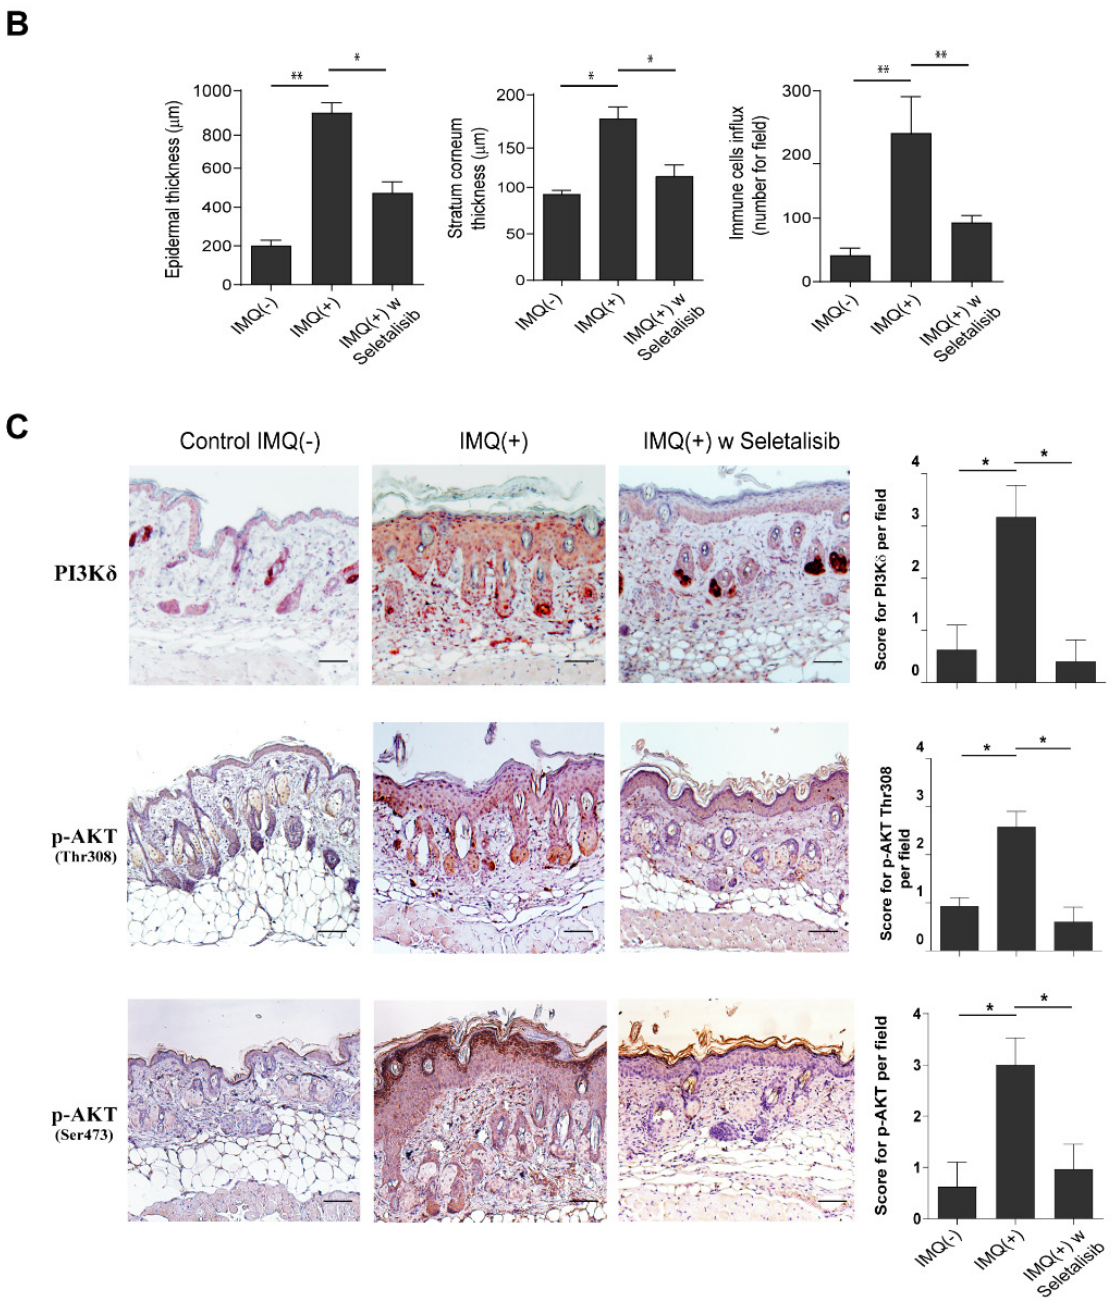
Figure 5. Ameliorative effects of seletalisib administration on pathological changes of IMQ-induced psoriasiform murine skin lesions. ( A ) Representative H&E staining of skin from Control IMQ ( − ), treated with IMQ cream (IMQ (+)), and IMQ-treated mice undergone to topical administration of seletalisib (IMQ (+) w seletalisib). Bars, 500 µ m. ( B ) The quantifications of epidermal and stratum corneum thickness, as well as of immune cell influx, were analyzed as parameters of skin acanthosis and inflammation. Graphs show means of microns of epidermis and stratum corneum thickness, and mean of number of infiltrating immune cells per section ( n = 3 sections) ± S.D. per group ( n = 2 mice for Control IMQ ( − ); n = 6 mice for IMQ (+) and n = 6 for IMQ (+) w seletalisib groups). * p ≤ 0.05 and ** p ≤ 0.01, as assessed by unpaired Student‘s t test. ( C ) IHC staining of PI3K δ isoform (red staining), p-AKT in Thr308, and in Ser473 (red-brown staining) was performed on skin of Control IMQ ( − ) ( n = 2), IMQ (+) ( n = 6), and IMQ (+) w seletalisib ( n = 6). Sections were counterstained with Mayer’s H&E and were visually evaluated by a pathologist experienced in dermatology. One out of six representative stainings is shown. Bars, 500 µ m. Graphs show the mean of four-stage score values for PI3K δ and p-AKT (Thr308, Ser473) ± SD per three sections per all mice of each experimental group. * p ≤ 0.05, as assessed by unpaired Student‘s t